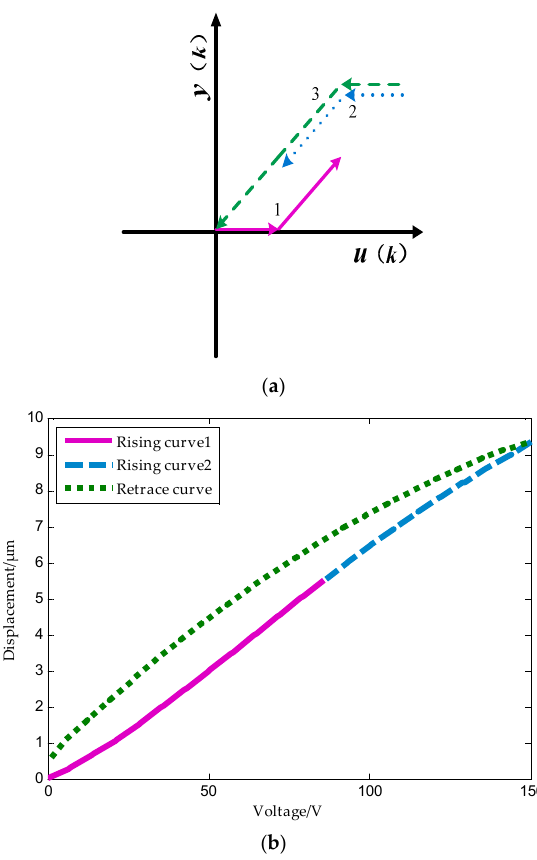
Figure 14. Relation of the play operator and the hysteresis curve.